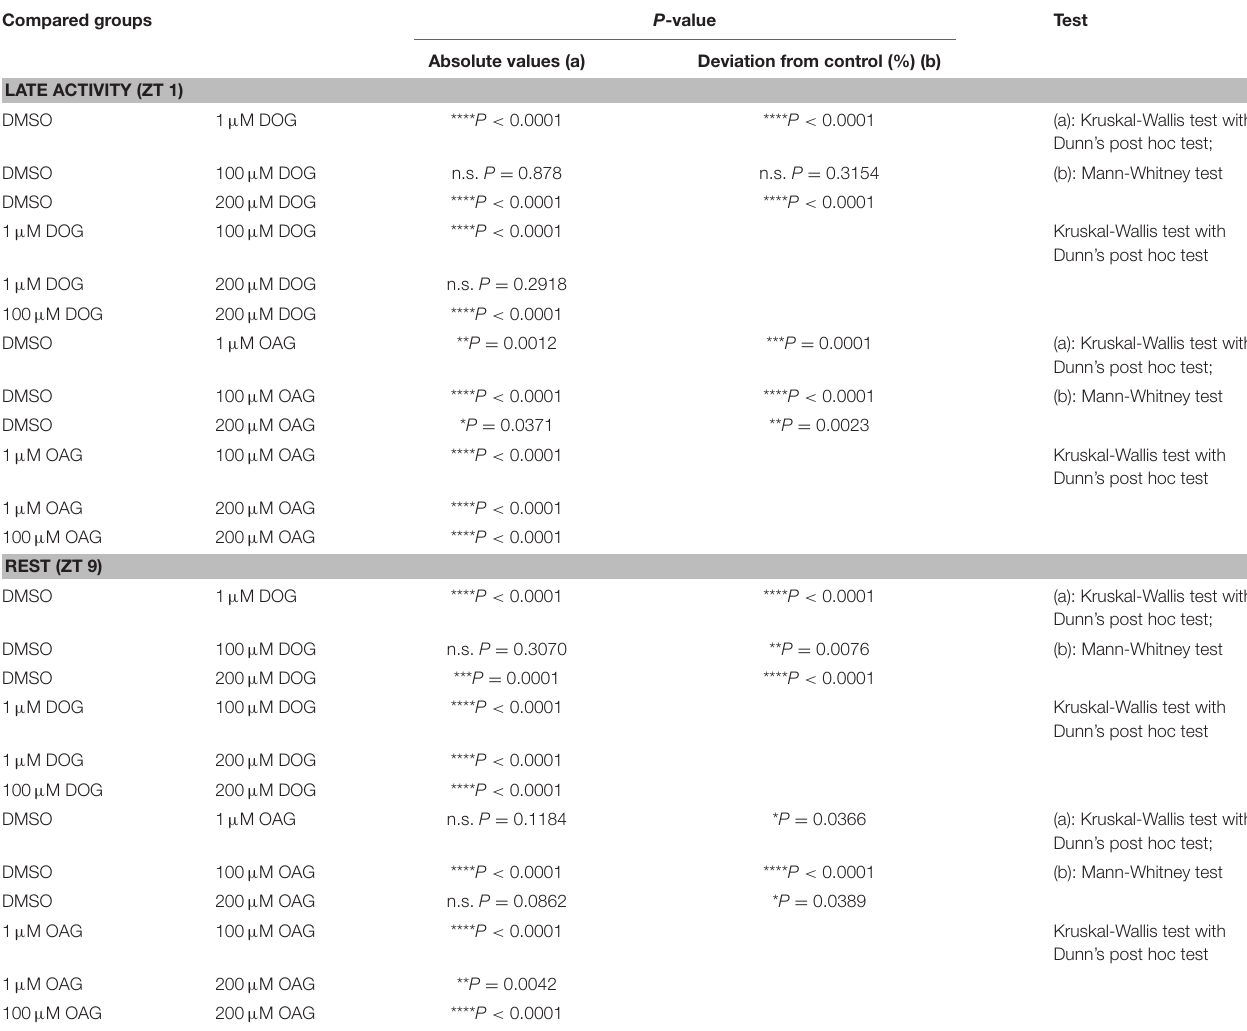
TABLE 2 | Statistical analysis of the normalized SPA of long-term recordings in the presence or absence of 1, 100, or 200 µ M DOG or OAG during the late activity phase and at rest ( Figure 3 ). Compared groups P -value Test Absolute values (a) Deviation from control (%)